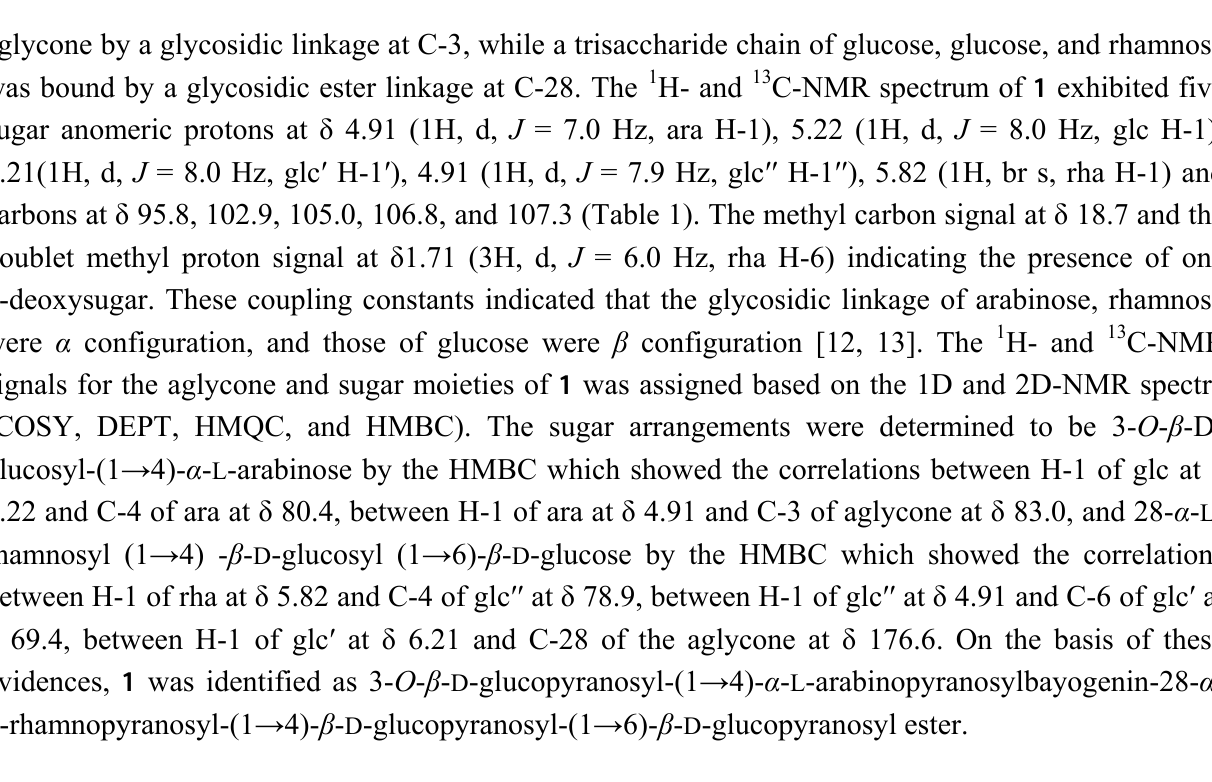
Table 1. 1 H- and 13 C-NMR spectral data of compound 1 (recorded at 500/125 MHz in ; δ in ppm, J in pyridine-d 5